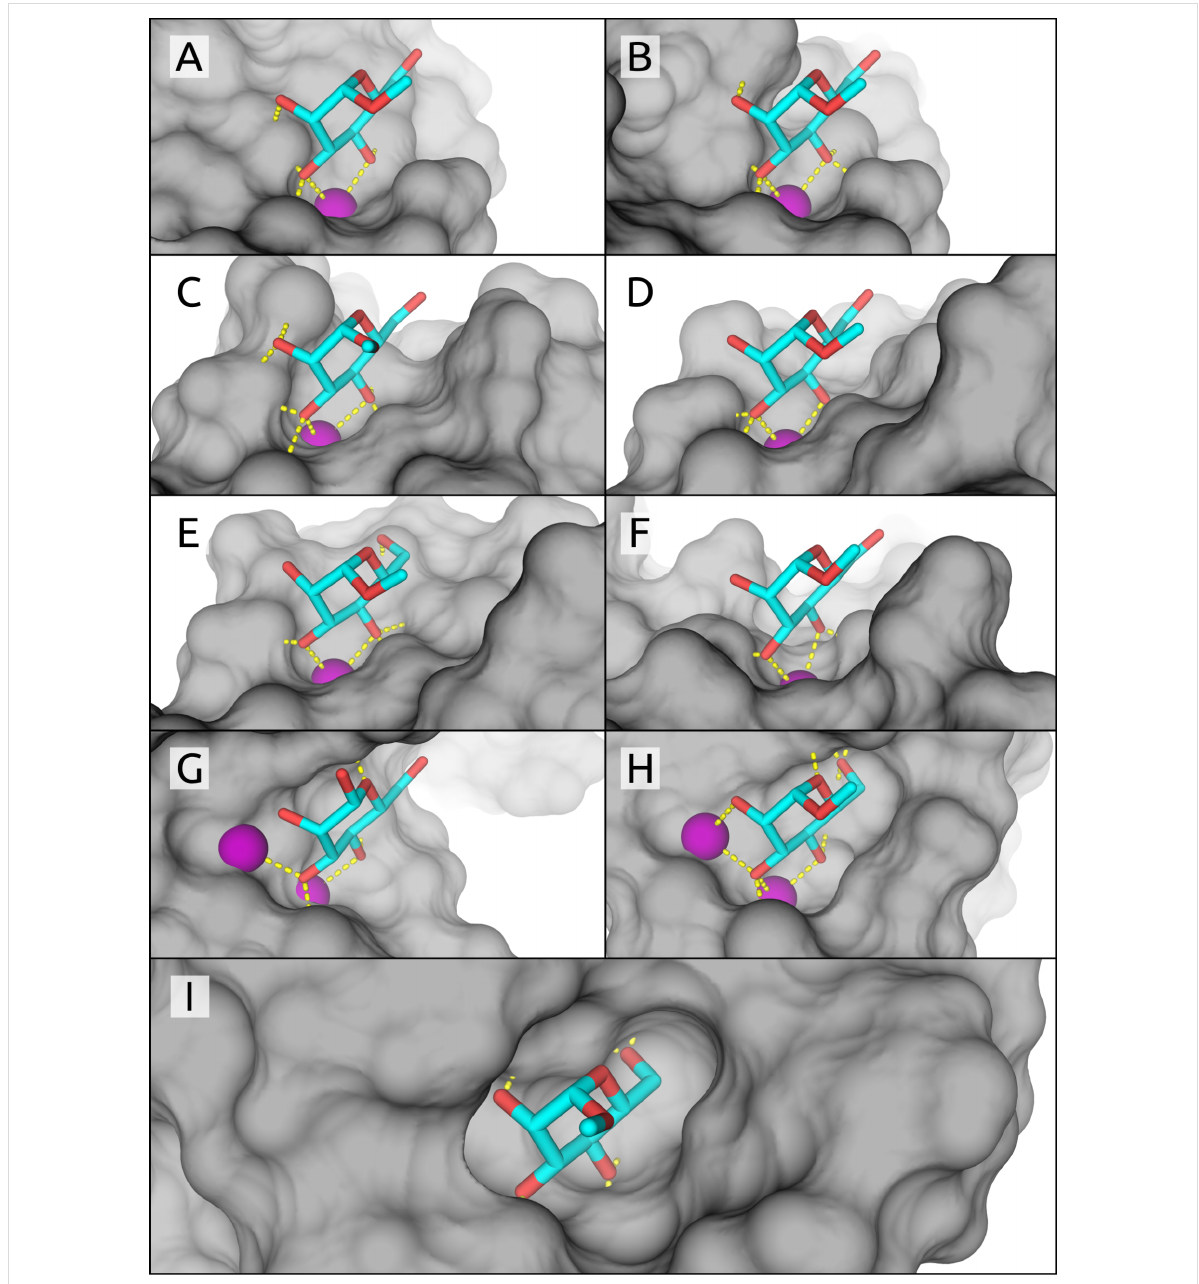
Figure 1: CRDs of the analyzed crystal structures, with mannose pyranosyl units similarly aligned in each structure. Mammalian lectins: ( A ) BDCA-2, ( B ) langerin, ( C ) SP-D, ( D ) DC-SIGNR, ( E ) DC-SIGN, ( F ) rat MBP; bacterial lectins: ( G ) LecB, ( H ) BC2L-A, and ( I ) FimH lectin domain.